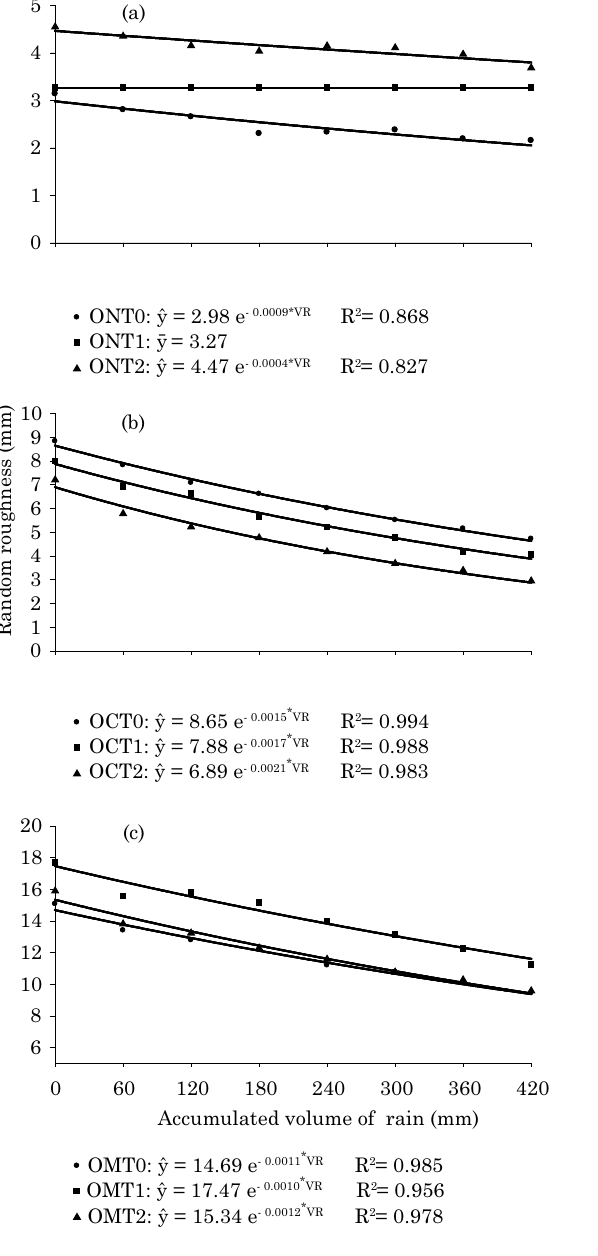
Figure 1. Random roughness of the soil surface (RR) as a function of the accumulated volume of rain (VR) under different rates of oat residue: (a) no tillage; (b) conventional tillage; and (c) minimum tillage. * significant at 5 % by the t test.